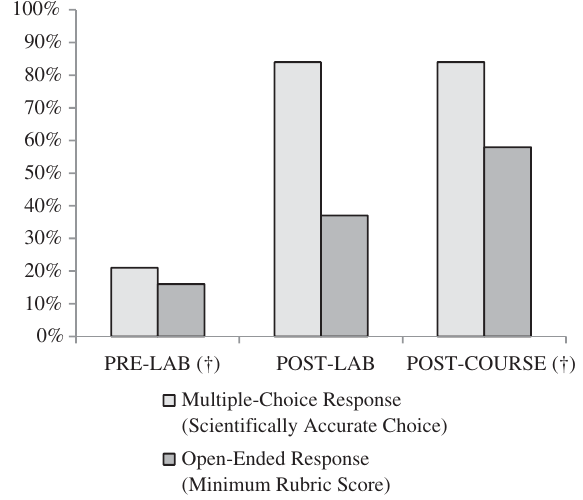
FIG. 6. Percentage of students meeting minimum criteria when asked about the Sun ’ s apparent motion with respect to the stars over a one day period ( n ¼ 19 ).